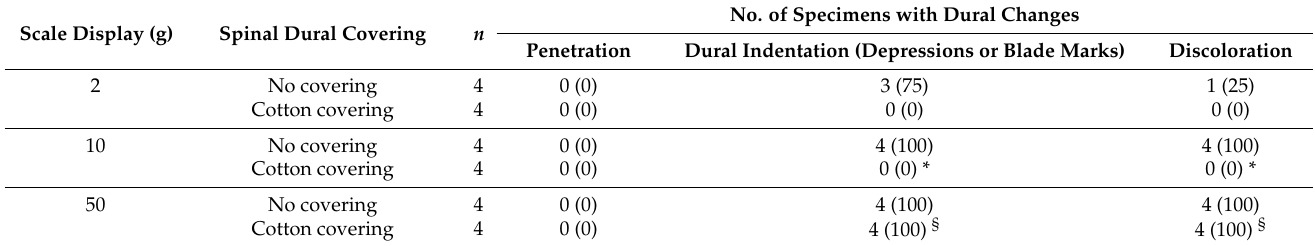
Table 1. Changes in the dura mater from ultrasonic bone curette oscillation (electron microscopy and stereomicroscopy).